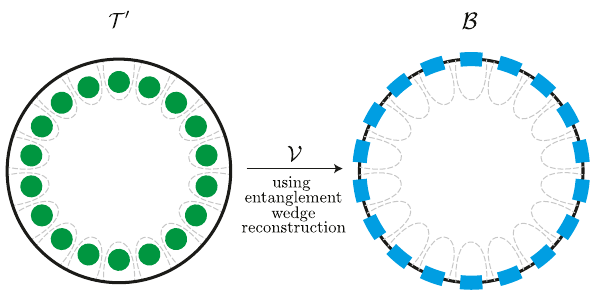
Figure 10. Depiction of the main part of the argument that holographic codes with full gauge- invariant Bulks automatically exhibit a gauge/global duality. The green dots represent the operators constituting the asymptotic symmetry transformation on the T system. They are each in an entanglement wedge of a small Boundary region and thus can be reconstructed as a product of operators along the T 0 system, depicted by the small blue rectangles, forming a global symmetry transformation. This part of the proof appears also in the proof of the same duality in AdS/CFT as shown in ref.